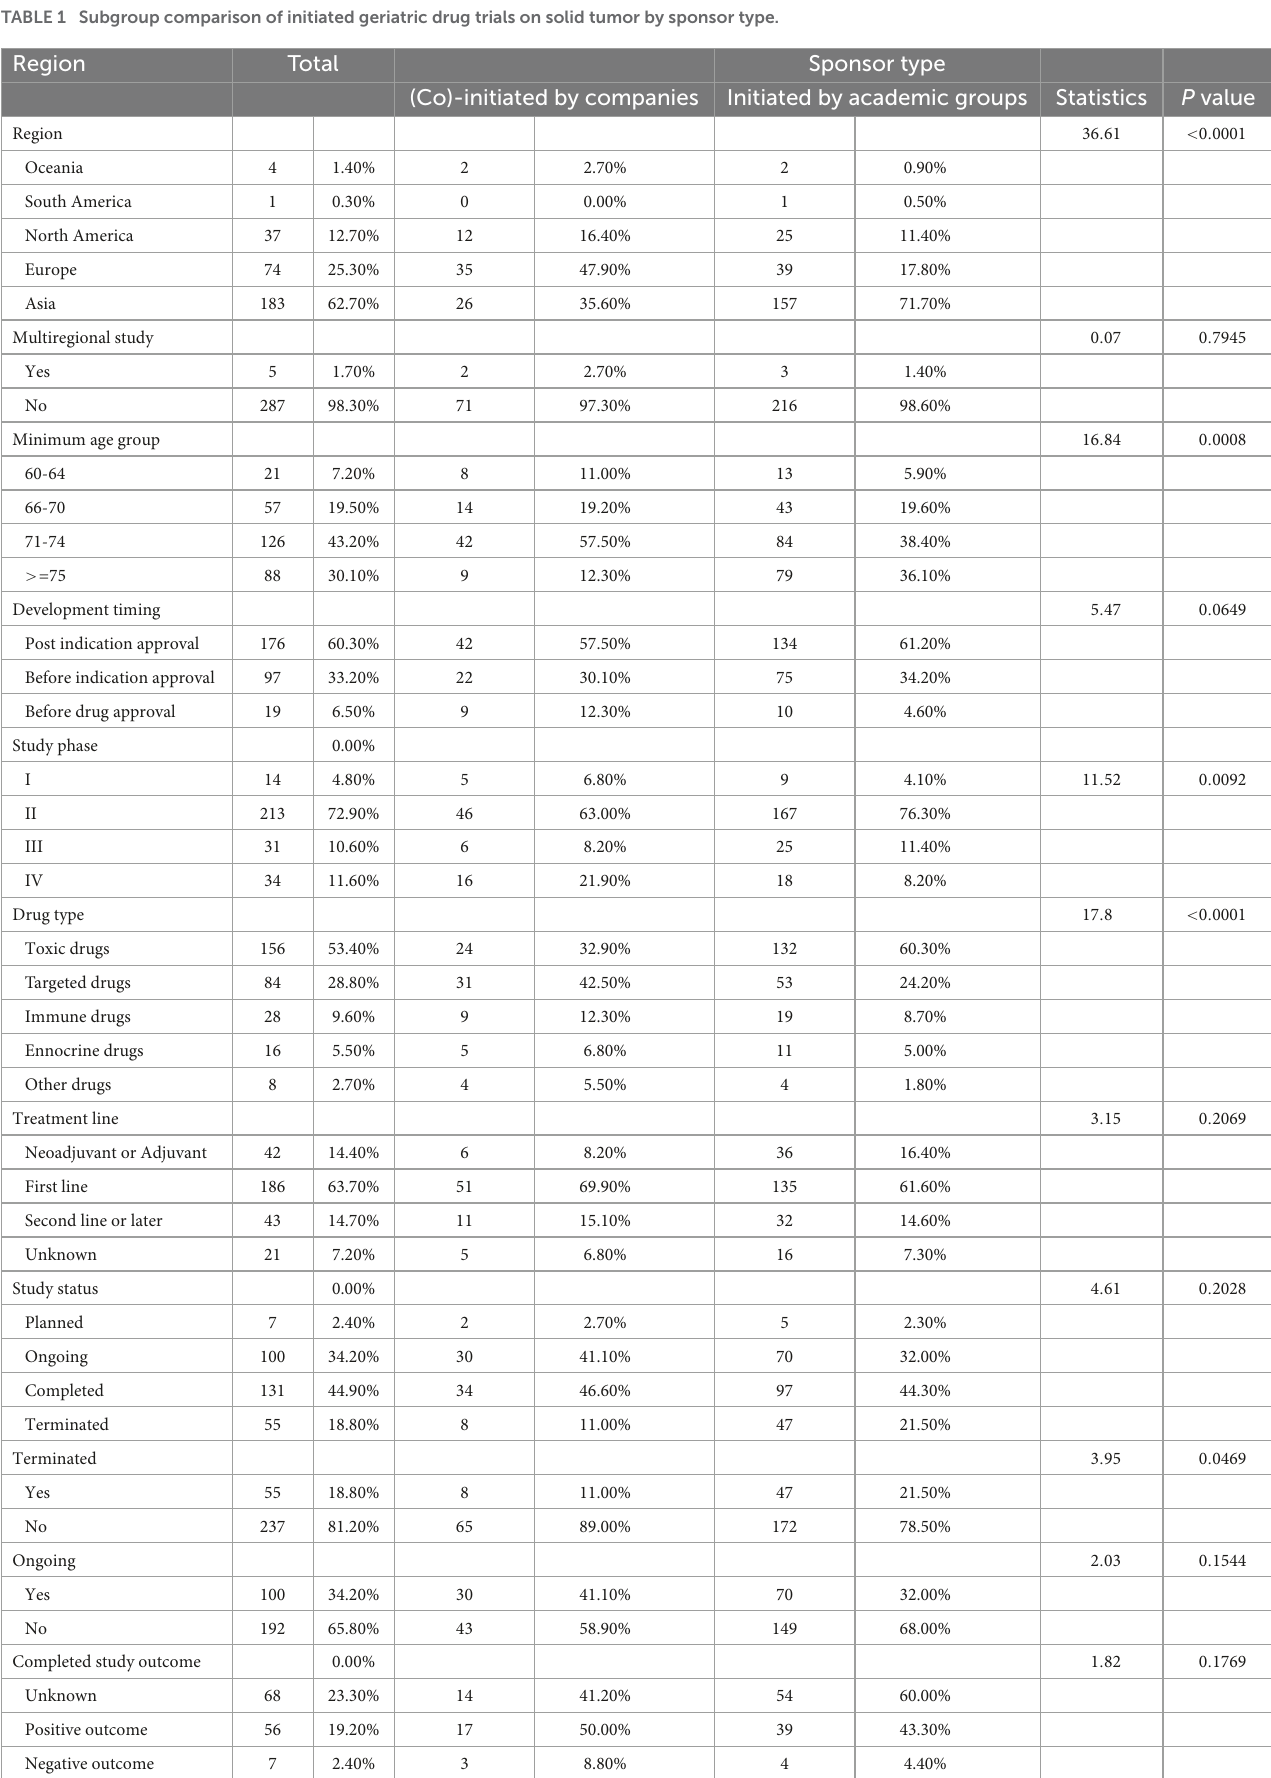
TABLE 1 Subgroup comparison of initiated geriatric drug trials on solid tumor by sponsor type. Region